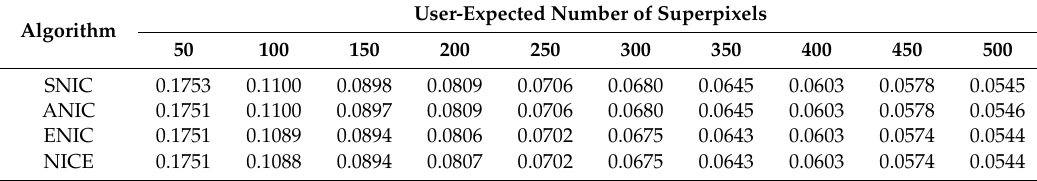
Table 2. Comparison of SNIC and the proposed three algorithms in terms of under-segmentation error (UE).